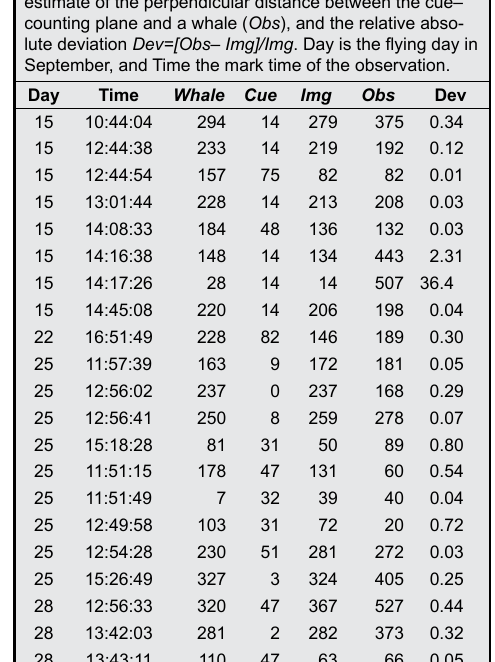
TABLE 1. The image based perpendicular distances (in meters) between the photo plane and a whale ( Whale ), the photo plane and the cue–counting plane ( Cue ), the cue– counting plane and a whale ( Img ), the observer based estimate of the perpendicular distance between the cue– counting plane and a whale ( Obs ), and the relative abso-